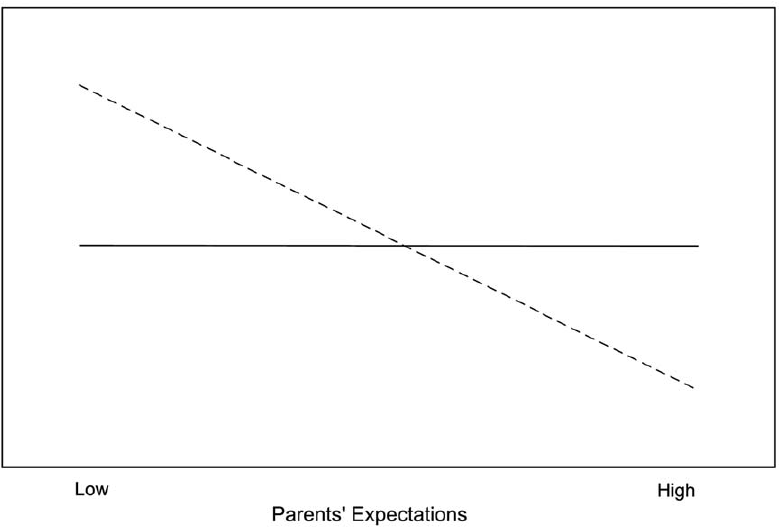
Figure 2. Associations between Parent’s Expectations and Victimization for DHH (dotted line) and Hearing Children separately.